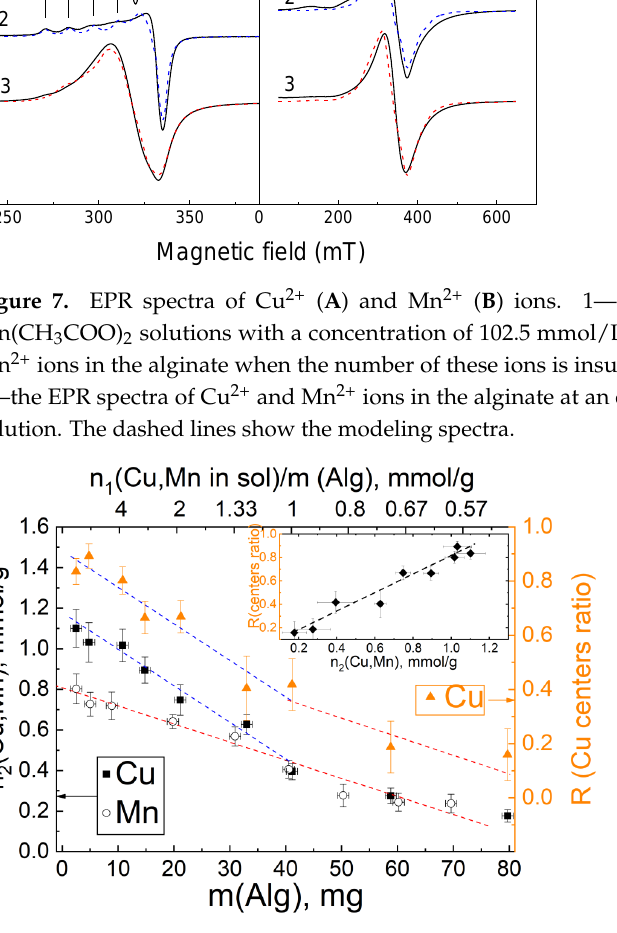
Figure 8. The measured value of concentration dependence (left axes) of Cu 2+ (black filled square) and Mn 2+ (black open circle) ions on the mass of ALG in 400 µ L solutions of Cu(NO 3 ) 2 or Mn(CH 3 COO) 2 with a concentration of 102.5 mmol/L. The ratio between the number of ions in the solution and the mass of the ALG sample ( n 1 ) is shown on top axis plots as recalculated bottom axes. The ratio R between the number of Cu pair centers and isolate Cu centers number (right axes) is shown as orange-filled triangles. With a large excess of Mn 2+ ions in the solution, the concentration n 2 reaches 0.8 mmol/g. With a decrease in the number of Mn 2+ ions in the solution, the concentration of ions in ALG–Mn also decreases (Figure 8, red dashed line), however, even at the smallest concentration, some of the Mn ions remain in the solution. It can be observed from Figure 7 that the EPR spectra of Mn 2+ practically do not change, only the uniform width of the EPR line changes, in accordance with the change in the concentration n 2 . The shape of the spectrum is characteristic of the EPR spectrum of the Mn presence in solids [29]. The ab- sence of the influence of a high concentration of paramagnetic impurity on the EPR spec- trum indicates a weak interaction between Mn 2+ ions; the ions are isolated from each other by alginate polymer molecules and do not form pairs. It can be assumed that the Mn 2+ ions occupy an alginate structure with the largest distance between the neighboring ions, ac- cording to the scheme described for barium in [3] or according to the “pocket-like” scheme proposed in [21]. Despite similar energies of Mn–O and Cu–O bonds [24], at high n 1 the cations form different structures in alginate. In contrast to Mn 2+ ions, the shape of the EPR spectra of Cu 2+ ions in ALG depends on the number of Cu 2+ cations in solution per 1 g of ALG, n 1 . For n 1 = 0.5 mmol/g, a powder- like EPR spectrum was registered with a clear hyperfine structure due to the nuclear mag- netic moment of Cu. The spectrum simulation with parameters of g xx = 2.067; g yy = 2.092; g zz = 2.387; A xx ,A yy < 80 MHz; A zz = 368 MHz; and g zz / A zz = 194 is shown in Figure 7А as a blue dashed line. Such parameters correspond to single Cu 2+ ions with octahedral coordi- nation in the plane of oxygen ions [30]. As the relative number of Cu 2+ cations n 1 increased to 16 mmol/g, the EPR spectrum became more symmetrical, without a pronounced hyper- fine structure. In [30–32], it was shown that such an EPR spectrum is characteristic of the